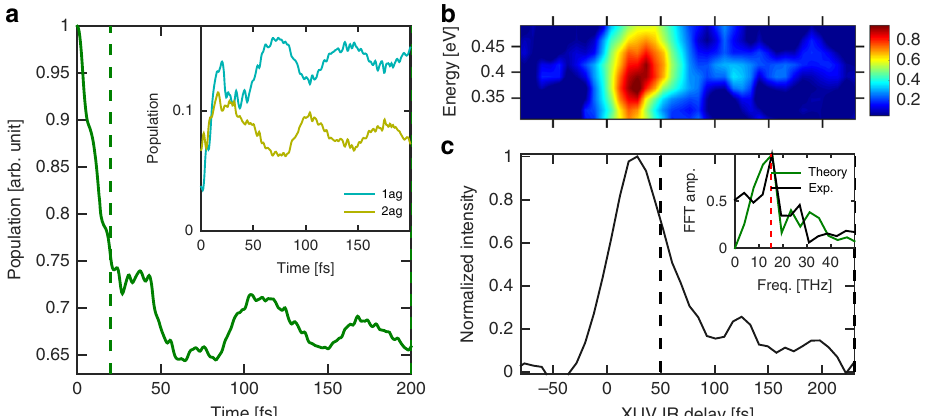
Fig. 4 Long-lived vibronic coherence. a Computed time-dependent population following ionization from 6a g orbital (see Fig. 2c) computed with the help of the constructed vibronic-coupling model. The periodic structures are attributed to the a g vibrational modes (see inset). The 2a g state belongs to the experimental probing region whereas 1a g lies below. b Measured time-dependent electron spectrum mapping the relaxation of the 6a g states. c Experimental signal integrated over the electron kinetic energy in the range 0.4 ± 0.075 eV. The inset shows the FFT of the experimental signal taken from 50 to 250 fs (black) compared with the theory taken from 20 to 200 fs (green). This leads to an oscillation period of 65